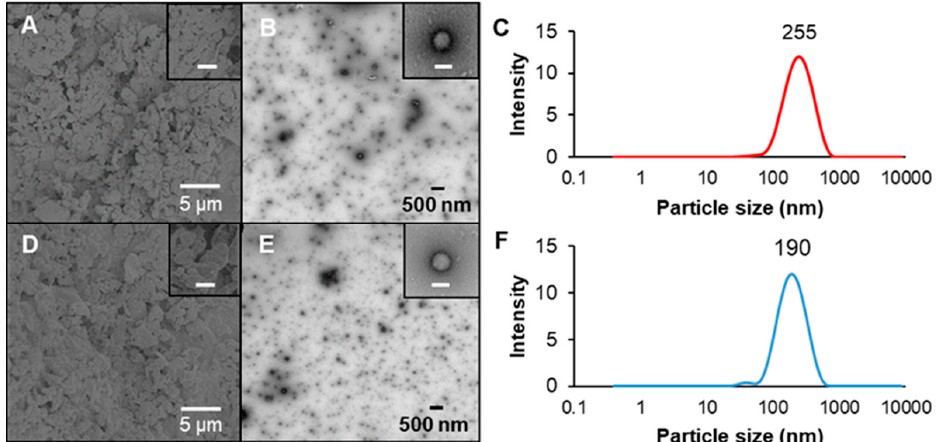
Figure 5. Characterization of spray-dried and redispersed nanoparticles. ( A ) and ( D ), SEM images of spray- dried powder; ( B ) and ( E ), TEM images of redispersed nanoparticles, along with ( C ) and ( F ), their respective size distribution measured by DLS. The ( A – C ) and ( D – F ) are obtained from nanoparticles prepared low and high concentration of oxidized dextran with 60 min heating time, i.e., NP1-60 and NP2-60, respectively. The scale bars in the inserted images in ( A ) and ( D ) are 2.5 µm, and in ( B ) and ( E ) they are 250 nm.